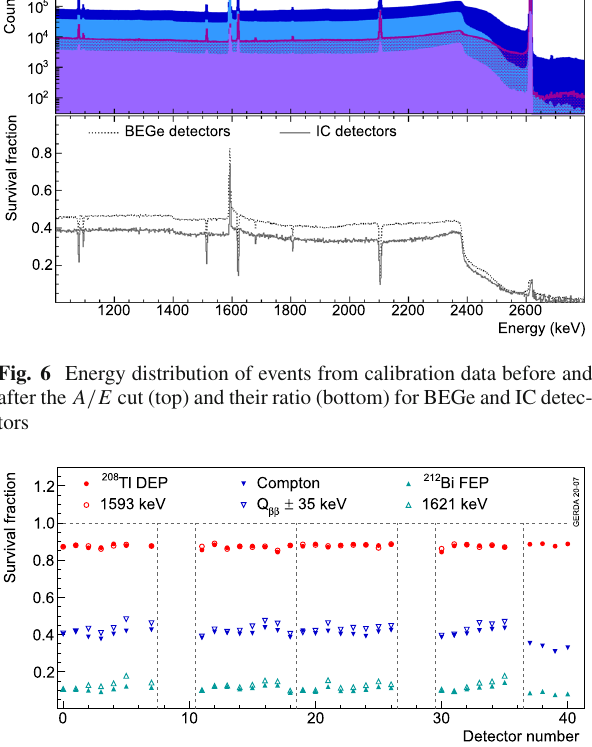
Fig. 7 Survival fraction of events in the 208 Tl DEP, 212 Bi FEP and CC( Q ββ )foreachdetector(seeTable3fordetectornumbersandtypes). Open (filled) symbols show the calibration dataset before (after) the upgrade. The dashed lines separate the detector strings in the array. The uncertainties are only statistical and smaller than the markers